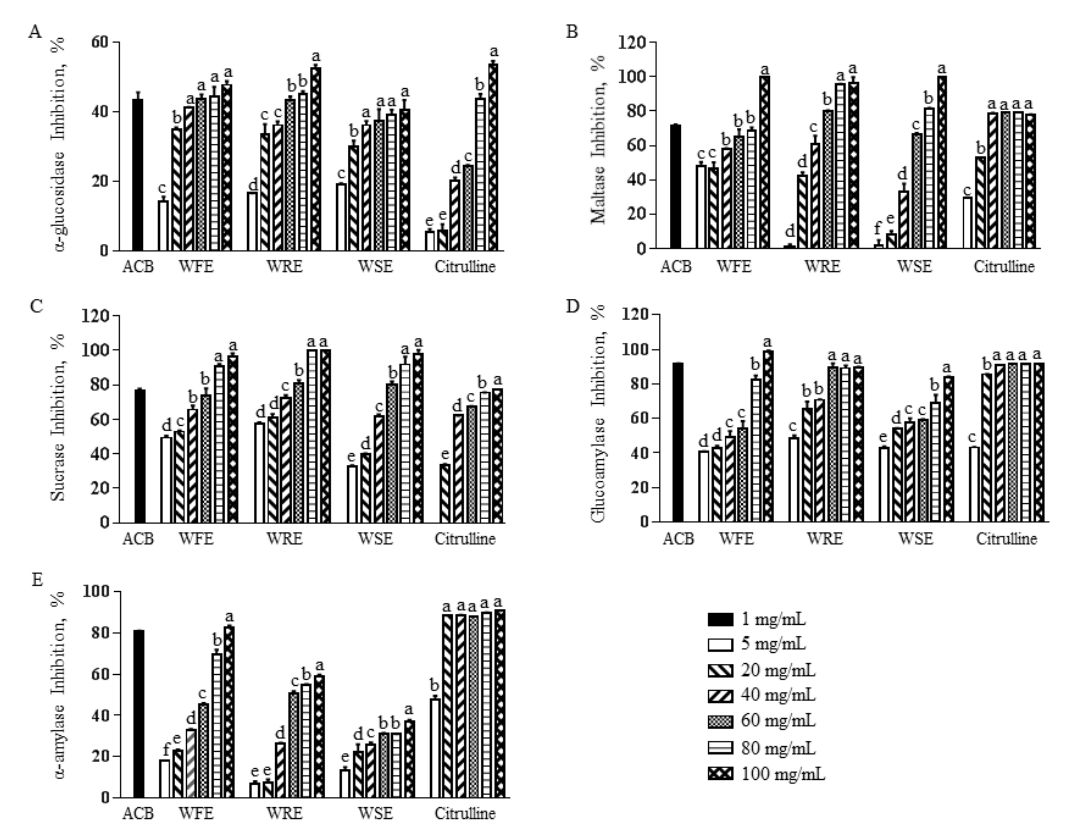
Figure 1. Effect of watermelon extracts and citrulline on carbohydrate-hydrolyzing enzymes. ( A ) α -glucosidase, ( B ) maltase, ( C ) sucrase, ( D ) glucoamylase, and ( E ) α -amylase activities of WFE, WRE, WSE, and citrulline at concentrations of 0, 5, 20, 40, 60, 80, and 100 mg/mL were determined. Acarbose (ACB, 1 mg/mL) was used as a positive control. Alphabet lower case letters indicate a statistically significant difference ( p < 0.05).